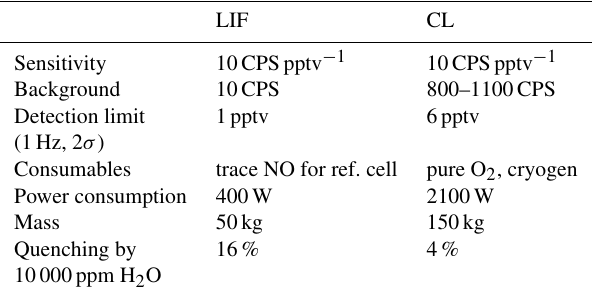
Table 1. Specifications of CL and LIF instruments compared on the NASA DC-8 during FIREX-AQ. The LIF instrument is a two channel-detector, while the CL instrument has four channels, in- cluding NO, NO 2 , NO y , and O 3 . Therefore, comparisons of weight and power of the instruments should consider these